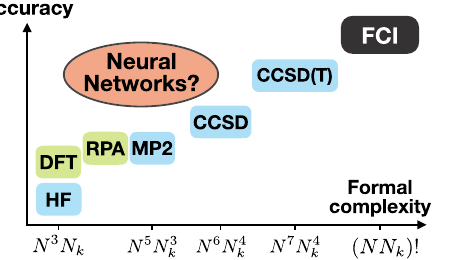
Fig. 1 Schematic illustration of the relationship between the formal computational complexity and accuracy in various fi rst-principles calculation methods for solid systems. Our goal is to demonstrate that the variational calculation using neural-network-based ansatz can readily describe both weakly and strongly correlated electronic structures with moderate number of variational parameters, i.e., computational cost. We denote the full con fi guration interaction (FCI) method by the black square, whereas the Hartree – Fock (HF) and post-HF calculation methods are indicated by blue squares: the second-order Møller – Plesset perturbation theory (MP2), the coupled-cluster singles and doubles (CCSD), and CCSD with perturbative triple excitations (CCSD(T)). Also, the green squares indicate methods based on the Density Functional Theory (DFT): the DFT and DFT-based Random Phase Approximation (RPA). The number of orbitals at each k -point is denoted as N and the total number of k -points as N k . Note that this is a qualitative (approximate) illustration, which will vary from case to